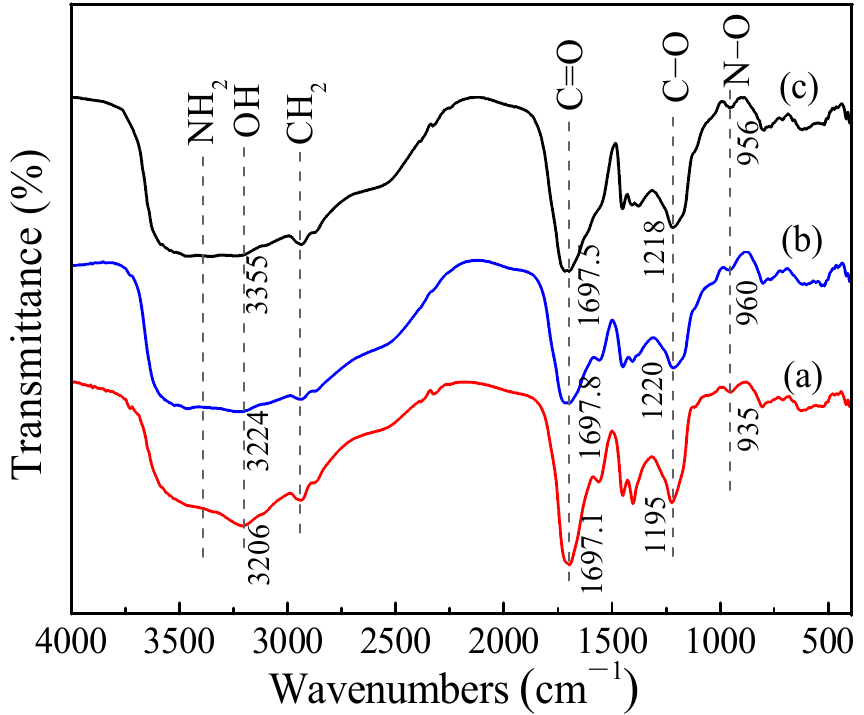
Figure 9. FT-IR spectra of ( a ) WAO and MT-WAO resins ( b ) before and ( c ) after the adsorption of Pb(II).